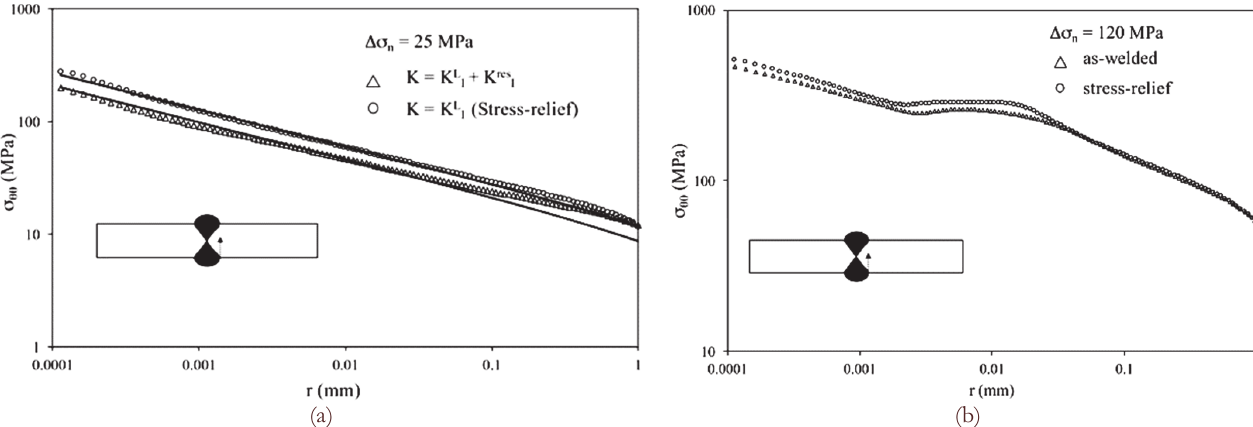
Figure 4: Maximum transverse stress field of stress-relief and as-welded joint after ten cycles at different values of the remotely applied stress amplitude ( Δσ n ) (a) Δσ n = 25 MPa; (b) Δσ n = 120 MPa; 2 β =135°, L solidification of the FZ: AA 6063, free edges